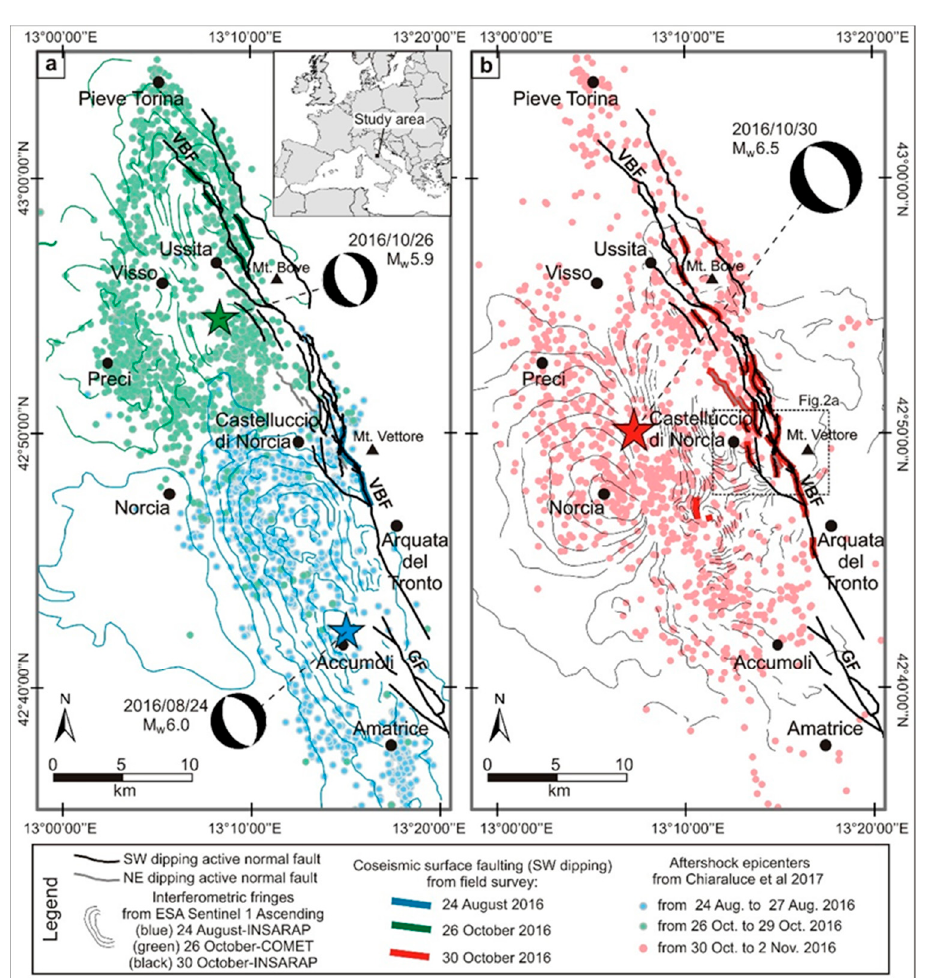
Figure 1. Seismicity along the Mt Vettore-Mt Bove Fault (VBF) and the associated coseismic deformation caused by the 2016 Central Italy seismic sequence. The inset shows the location of the study area in the Central Apennines of Italy. In the maps, the thick black lines show the trace of the VBF, with coseismic surface ruptures caused by ( a ) the 24 August Mw 6.0 (thick blue lines) and 26 October, Mw 5.9 (thick green lines) foreshocks and ( b ) 30 October Mw 6.5 mainshock (thick red lines). Stars locate the epicenters of the Mw 6.0 and Mw 5.9 foreshocks (blue and green star in a respectively) and the Mw 6.5 mainshock (the red star in b ); the corresponding focal solutions are also shown. Small dots in ( a ) represent the relocated epicenters 0.7 < Mw < 4.8 during the 3-day period after the 24 August (blue